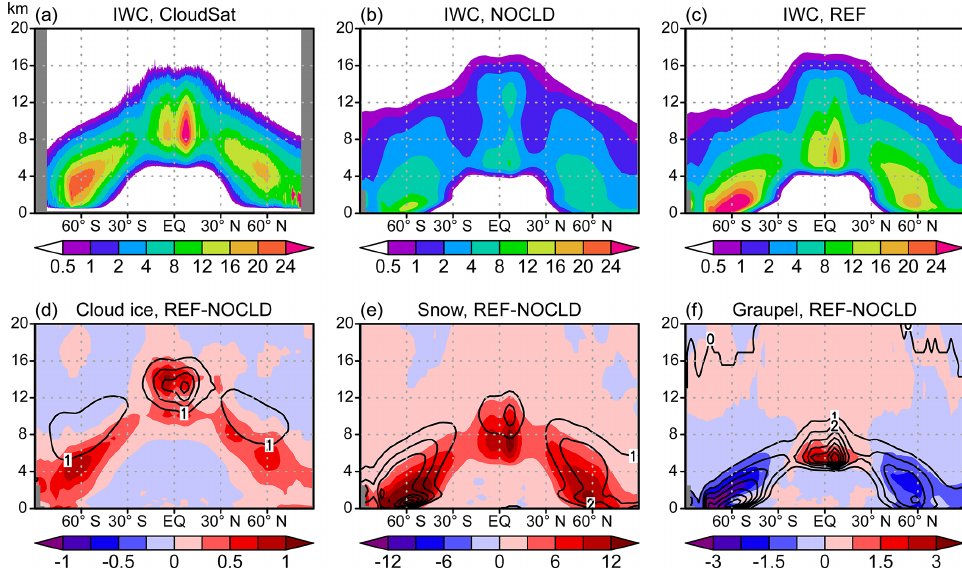
Figure 6. Annual mean of the zonal mean ice water content (10 − 6 kgm − 3 ) in CloudSat observations (a) and the NOCLD (b) and REF (c) runs by NICAM16-9S. The breakdown of the simulated ice water content (IWC) into cloud ice (d) , snow (e) , and graupel (f) is shown in the bottom panels. The contours show the NOCLD run and shading shows the difference between the REF and NOCLD runs. The analysis data are 0.25 ◦ (a) and 2.5 ◦ (b–f) gridded data, and the vertical axis is the altitude in km above sea